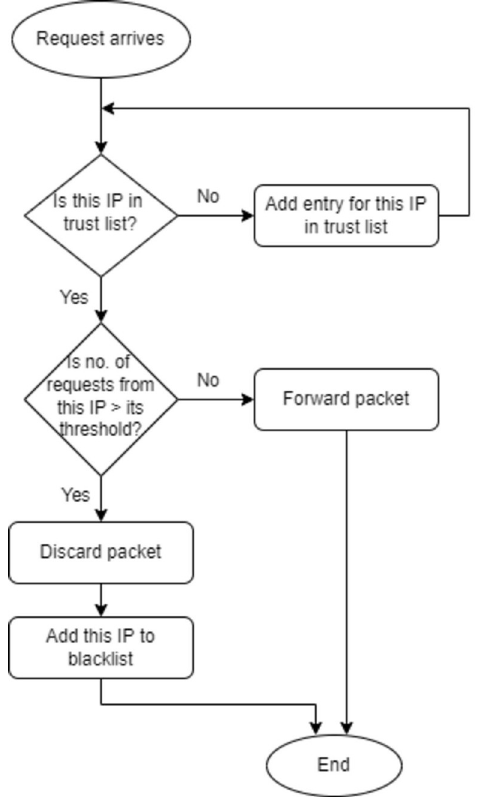
Fig 2. The proposed DDOS attack detection